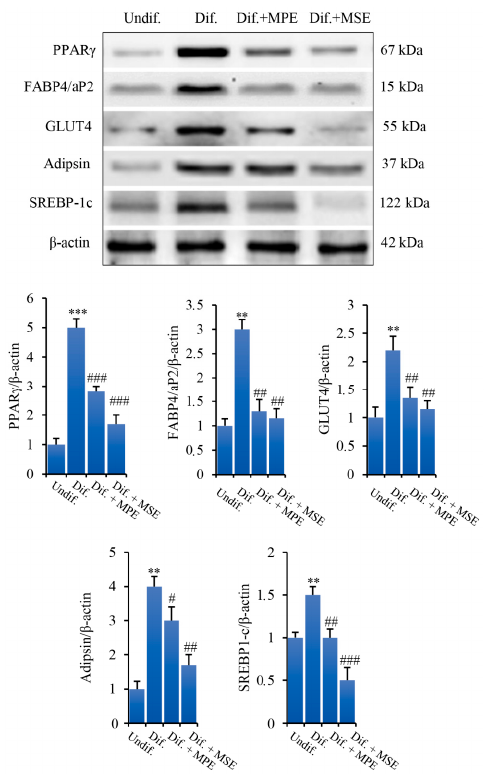
Figure 4. MPE and MSE down-regulate the expression of adipogenic differentiation and lipid accumulation markers in 3T3-L1 adipocytes. 3T3-L1 cells were treated with pro-differentiative agents for 8 days in the presence or absence of 100 µg/mL MPE or MSE, as reported in Methods. Then, cell lysates were analysed by Western blotting using specific primary antibodies directed against PPAR γ , FABP4/aP2, GLUT4, Adipsin and SREBP1-c. Equal loading of proteins was verified by immunoblotting for β -actin and showed values were assigned in relation to undifferentiated cells (Undif.). The bar graphs represent the mean of three independent experiments ± SD. ** p < 0.01 and *** p < 0.001 with respect to undifferentiated 3T3-L1 cells (Undif). # p < 0.05, ## p < 0.01 and ### p < 0.001 with respect to the differentiated untreated 3T3-L1 cells